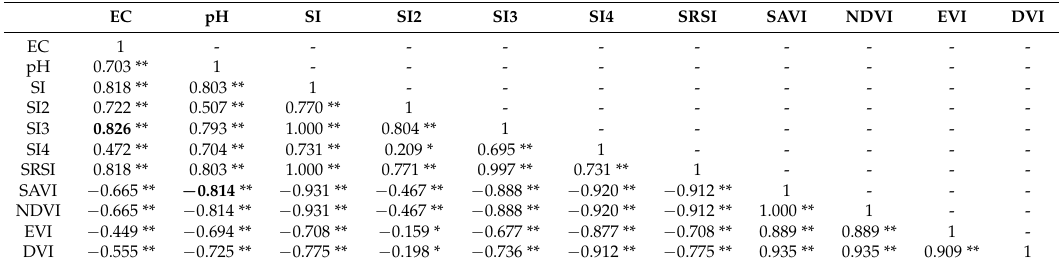
Table 3. Correlation coefficients between spectral indices, soil pH and